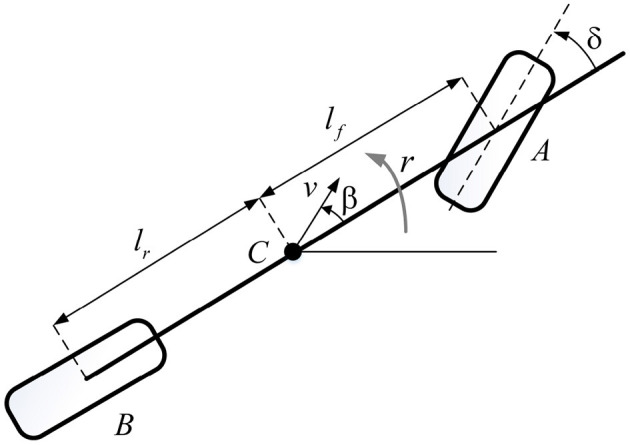
Two-degree-of-freedom bicycle model of vehicle.